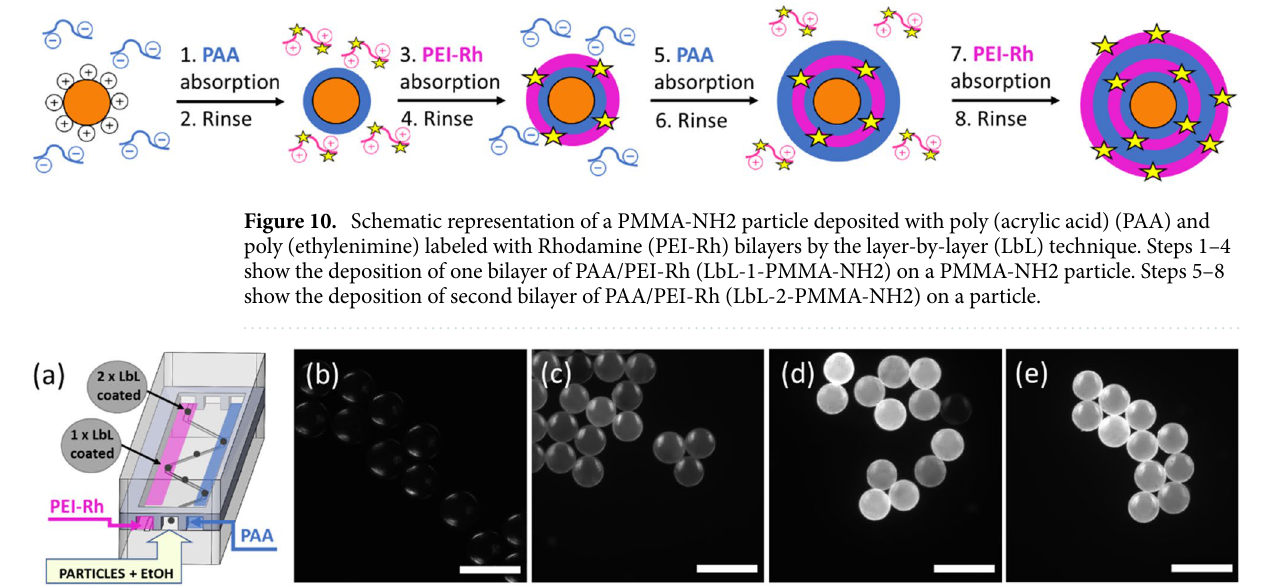
Figure 11. ( a ) Schematic representation of PMMA-NH2 particles deposited with poly (acrylic acid) (PAA) and poly (ethylenimine) labeled with Rhodamine (PEI-Rh) bilayers by the layer-by-layer (LbL) technique on chip. ( b–e ) Fluorescence photographs of PMMA-NH2 magnetic particles: ( b ) particles without coating (control), ( c ) particles with one bilayer (LbL-1-PMMA-NH2), coated in batch, ( d ) particles with two bilayers (LbL-2- PMMA-NH2), coated in batch, ( e ) with two bilayers (LbL-2-PMMA-NH2), coated on chip. Scale bars are 200